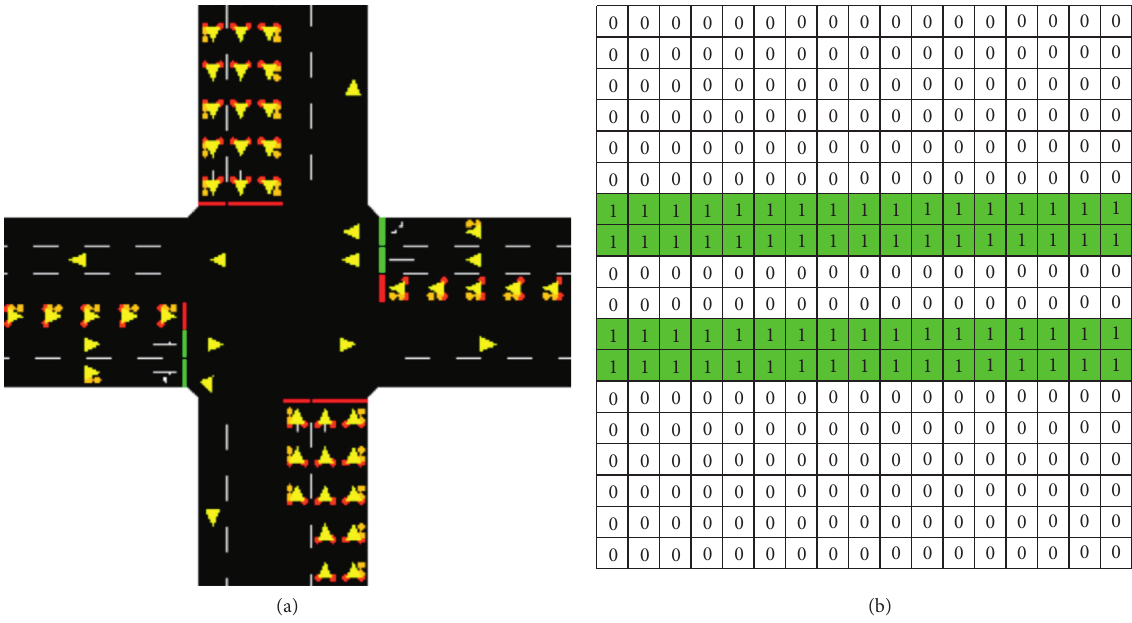
Figure 5: Example of processing map of signal phase. (a) Simulation interface. (b) Map of signal phase.